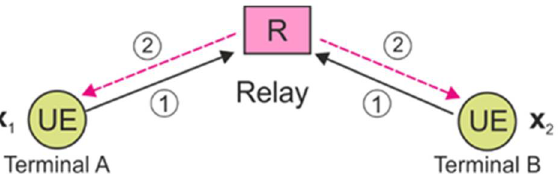
Figure 2. General scheme of a two-way relaying system with physical layer network coding.